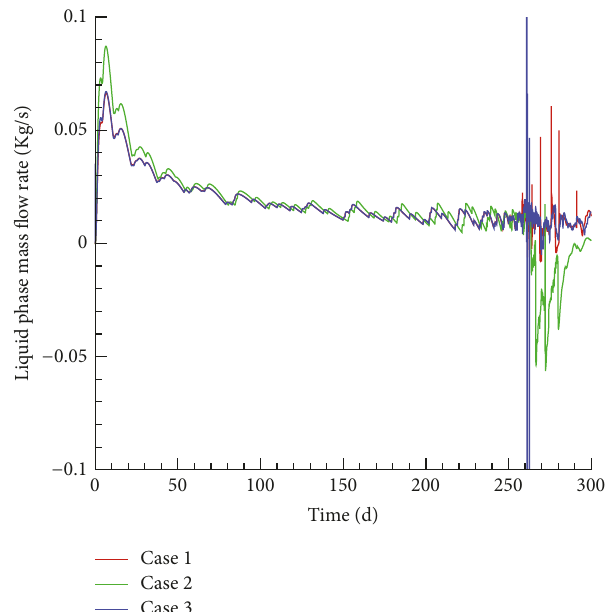
Figure 15: Evolution of liquid phase mass flow rate into Aquifer 2 from the beginning of CO 2 injection until the end of 300th